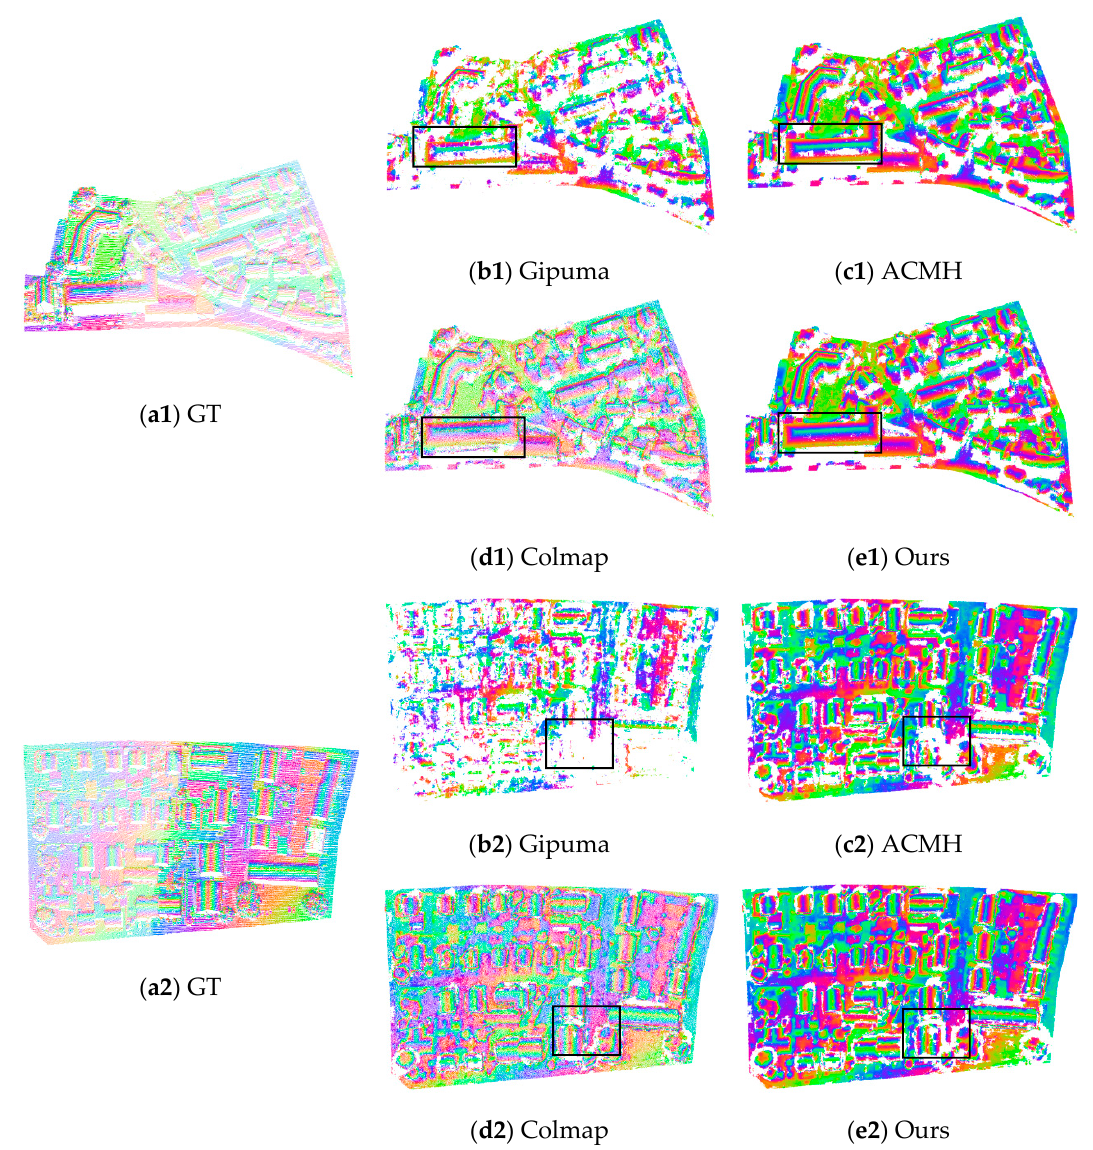
Figure 12. The comparison of reconstructed point clouds with test site 1 and test site 3 in the Vaihigen dataset. ( a1 , a2 ) are the ground truth point clouds of test site 1 and test site 3, respectively. ( b1 – e1 ) and ( b2 – e2 ) are generated by Gipuma, ACMH, Colmap, and the proposed method with test site 1 and test site 3, respectively.